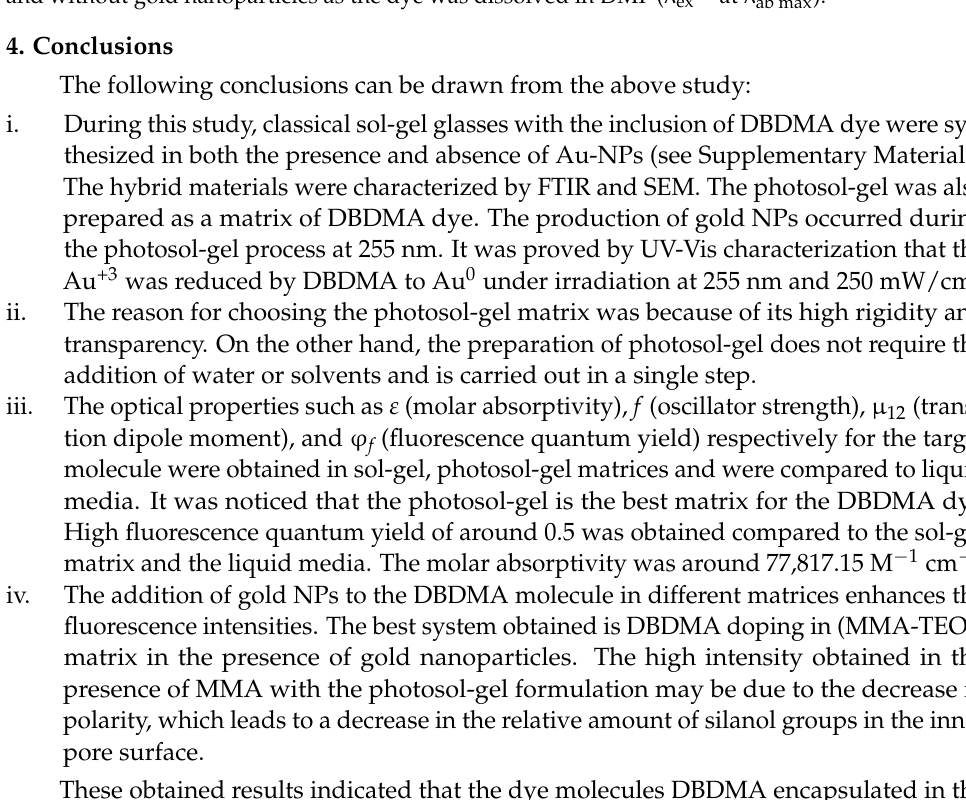
Figure 4. Comparison of 1.41 × 10 − 5 M DBDMA fluorescence intensity in different solid media with and without gold nanoparticles as the dye was dissolved in DMF ( λ ex = at λ ab max ).